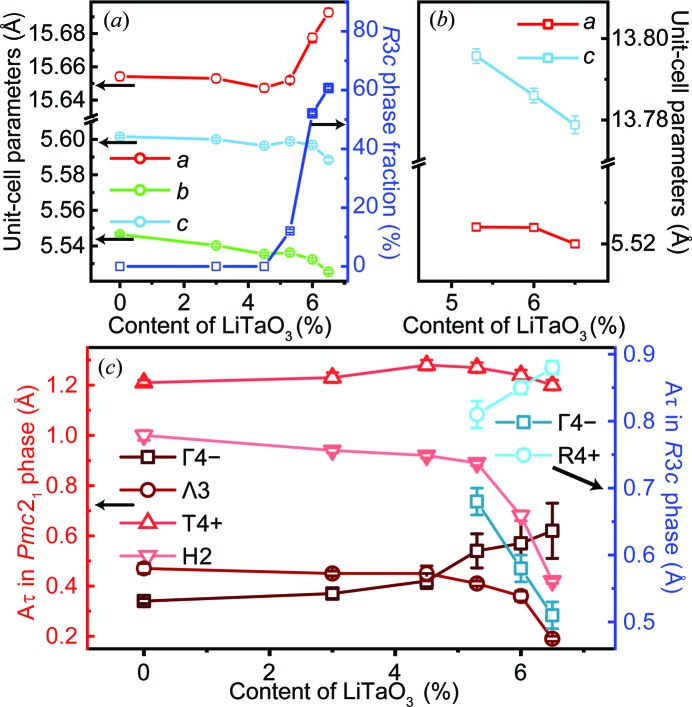
(a) Refined lattice parameters of the Pmc21 phase and the phase fraction of the R3c phase. (b) Lattice parameters of the R3c phase. (c) The global amplitudes of the main modes in both the Pmc21 and R3c phases, changing as a function of LiTaO3 content.